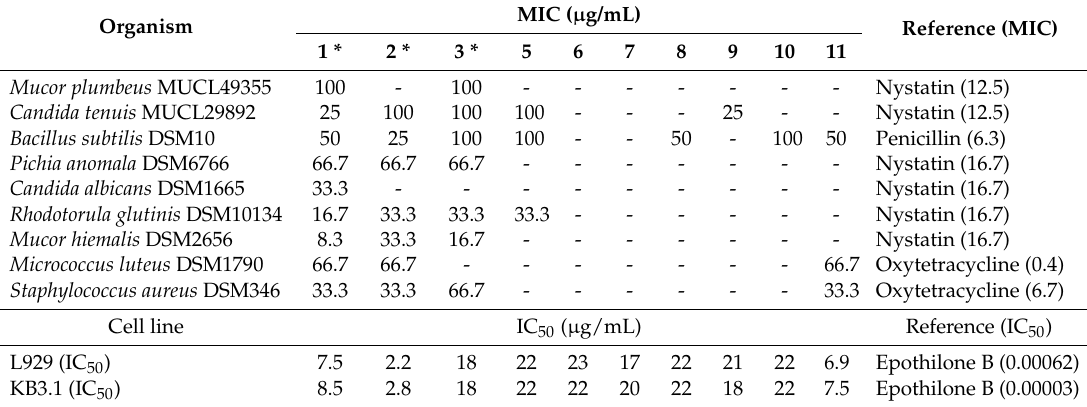
Table 3. Minimum inhibitory concentration (MIC) in the serial dilution assay for bacteria and fungi and half-inhibitory concentrations (IC 50 for cell lines) in µ g/mL. For determination of MICs, 20 µ L of either was adjusted to 6.7 × 10 5 cells/mL. Twenty microliters of Ethanol were used as negative control and displayed no activity against the selected test organisms. For IC 50 values, 6 × 10 3 cells/well were sown in 96-well microtiter plates and treated with 1 – 3 , 5 – 11 over five days.